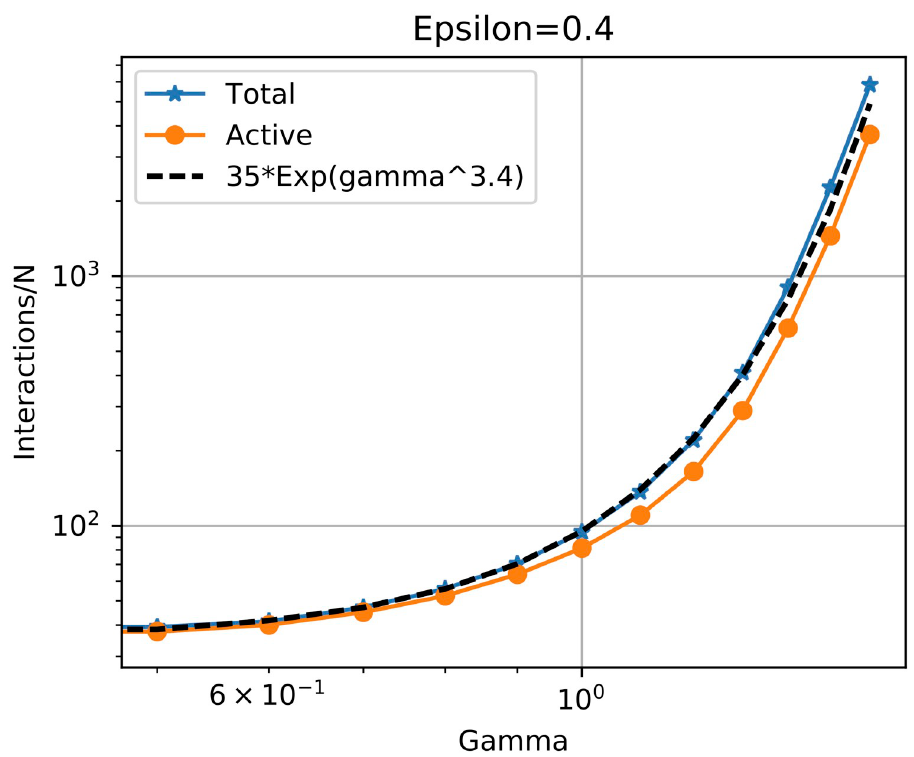
Fig 4. Time to convergence. Normalized total, non-null difference and active number of interactions required for convergence for ε = 0.4. The reference 35exp( γ 3.4 ) is shown as a visual aid only.